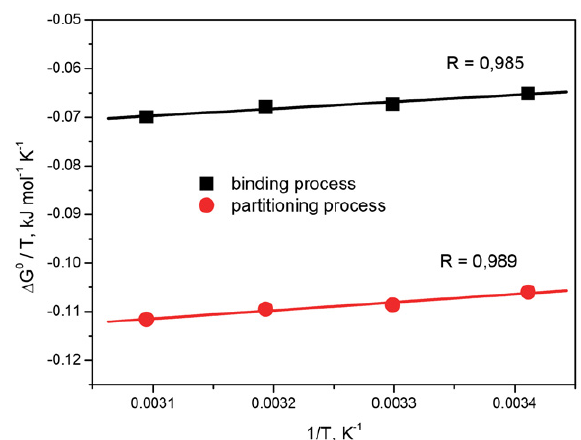
Figure 7. Plot of ΔG 0 /T versus 1/T for the binding and partitioning of quinizarin to SDS